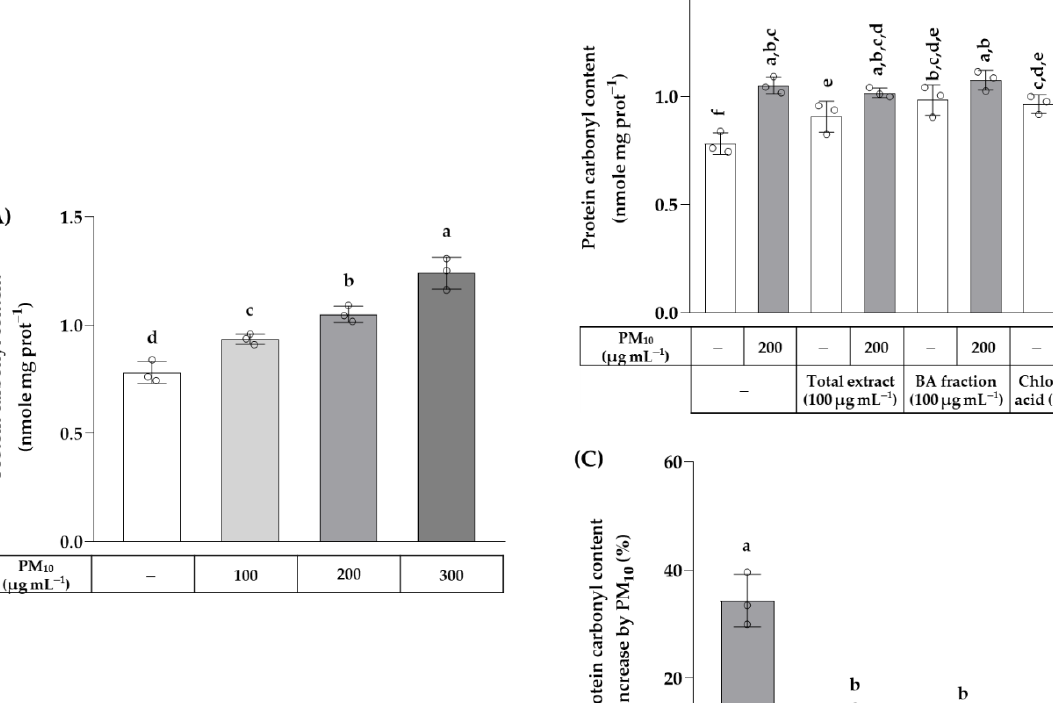
(100 μg mL −1 ), chlorogenic acid (100 μM), and NAC (100 μM) did not affect the secreted level of PG E 2 in the absence of PM 10 . The BA fraction (100 μg mL −1 ) and chlorogenic acid (100 μM) inhibited the increase in the secreted level of PG E 2 in cells stimulated by PM 10